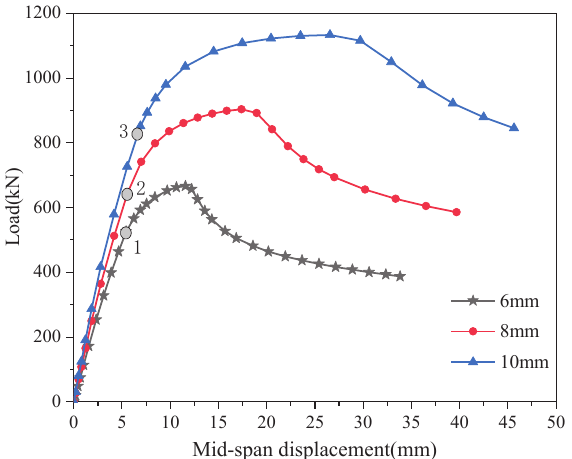
Figure 19. Load-mid-span displacement curves of composite beams with different U-rib